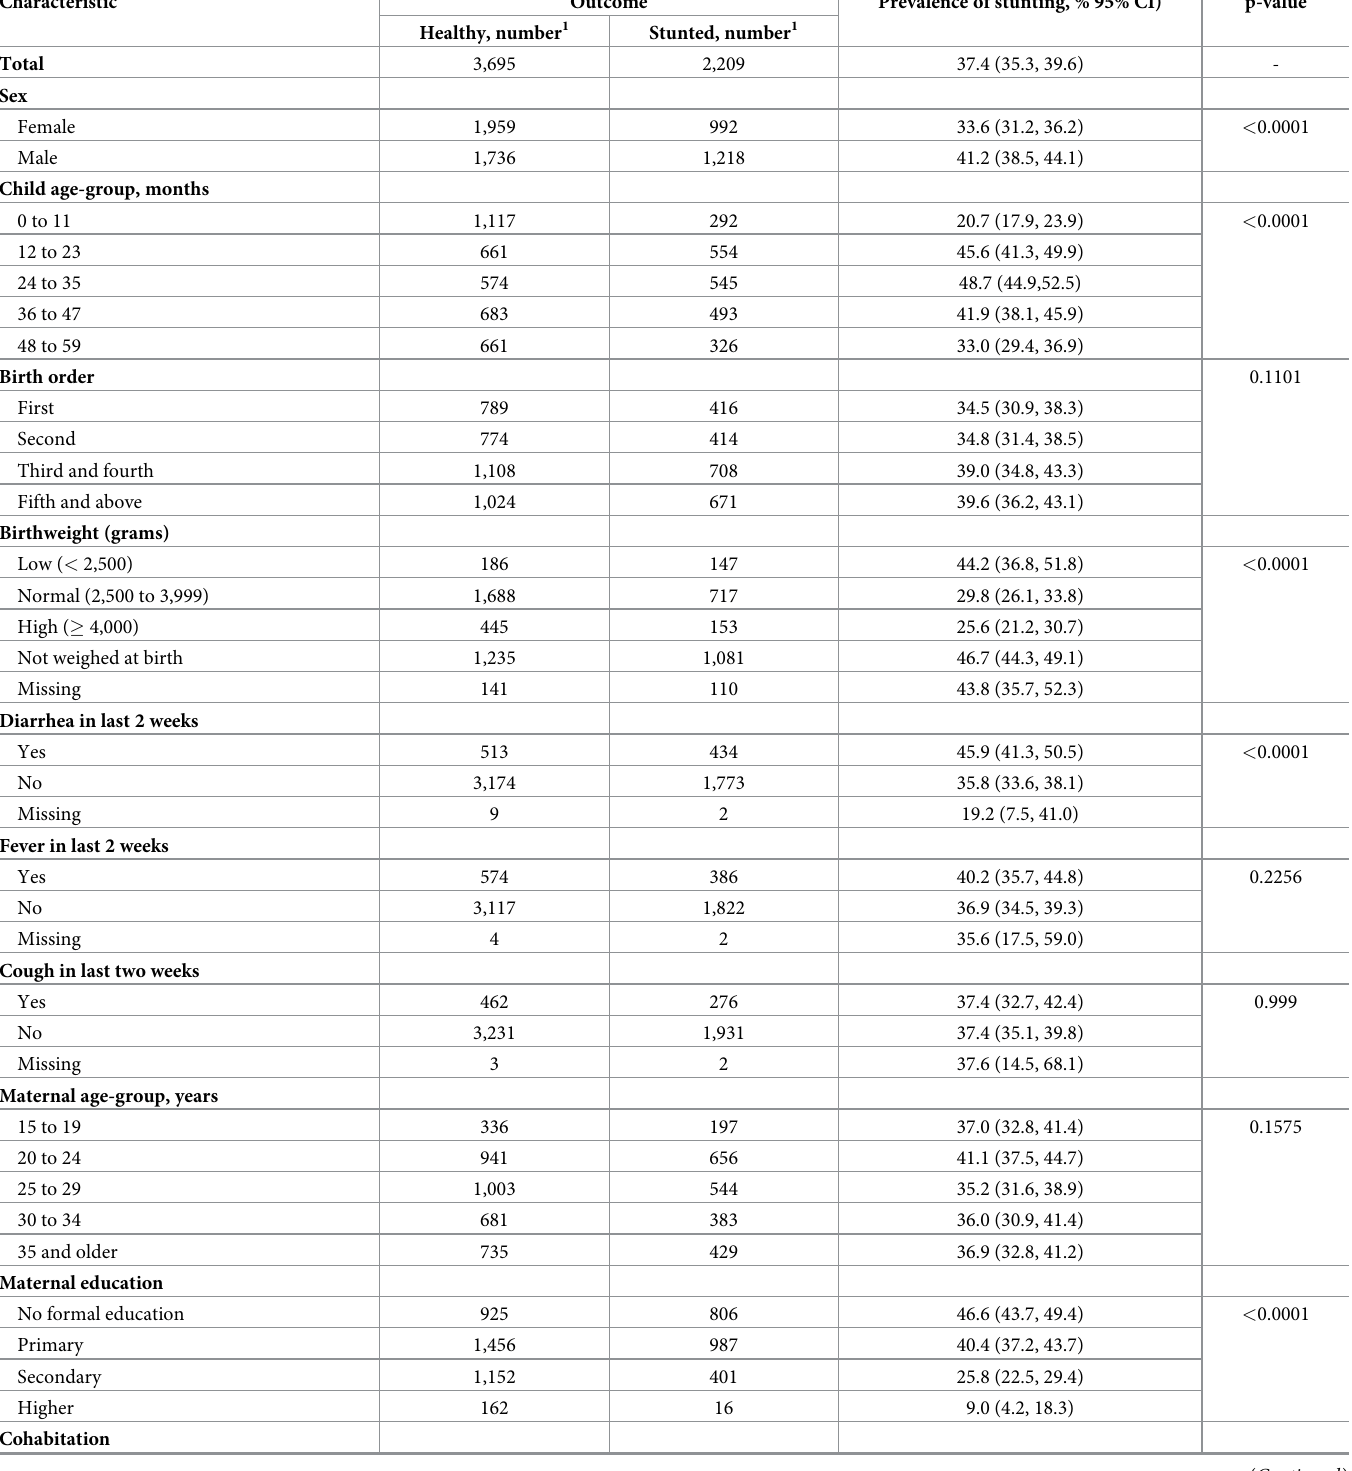
Table 1. Number of children 0 to 59 months of age according to characteristics of participants and households, and prevalence of